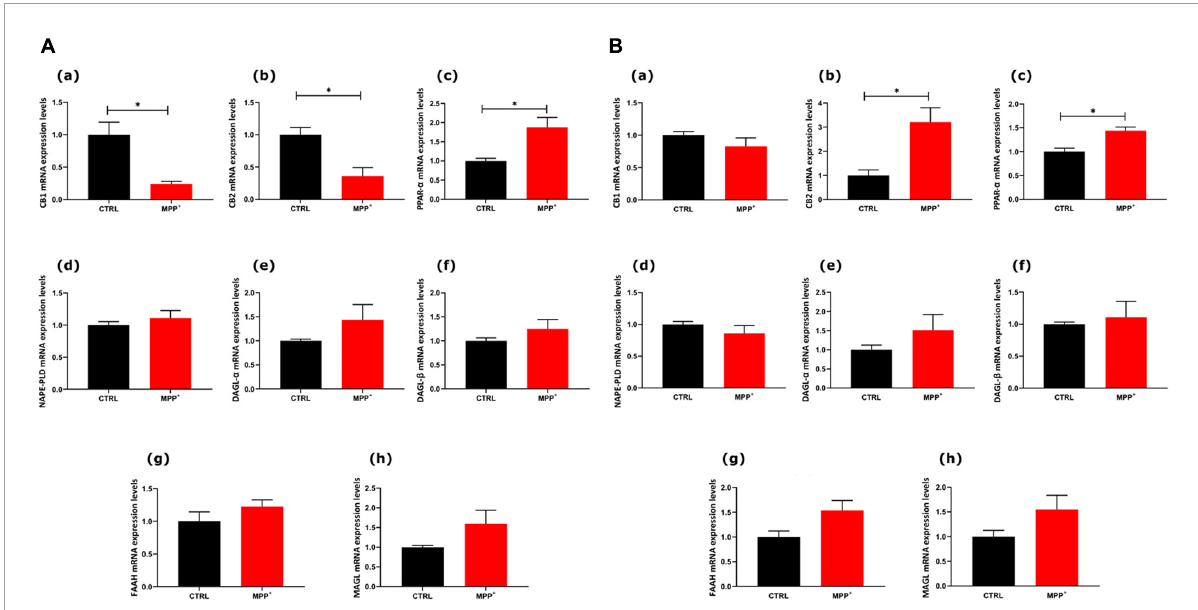
FIGURE2 mRNA expression levels of indicated genes analyzed by quantitative PCR analysis. Differences in mRNAs content between groups were expressed as the 2 − (cid:49)(cid:49) Ct formula as reported in the material and method section in not differentiated (A) and differentiated (B) SH-SY5Y cells. Data are represented as mean ± SEM of at least three independent determinations. The asterisk ( ∗ ) indicates a p < 0.05 vs. the control (veh)